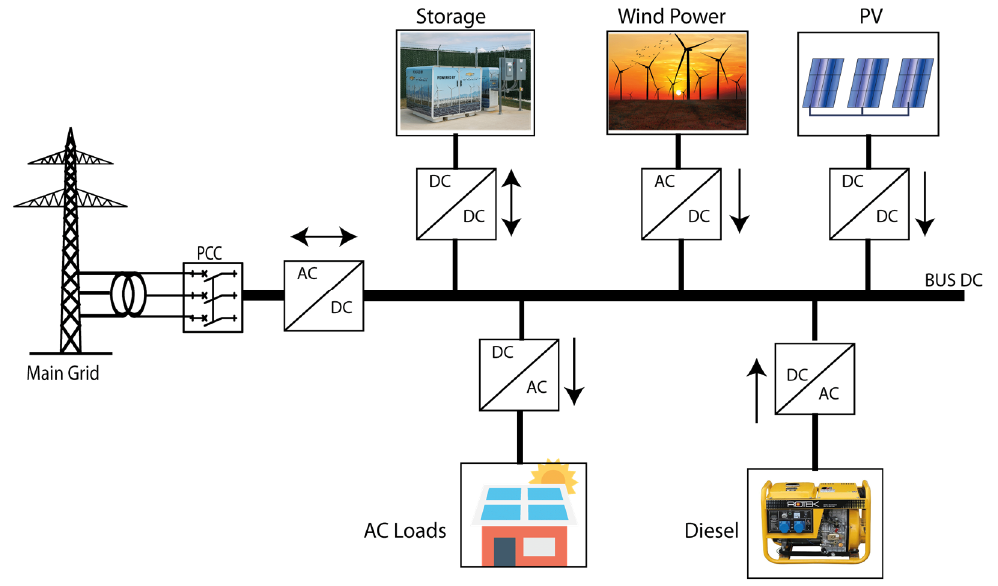
Figure 1. Microgrid structure.